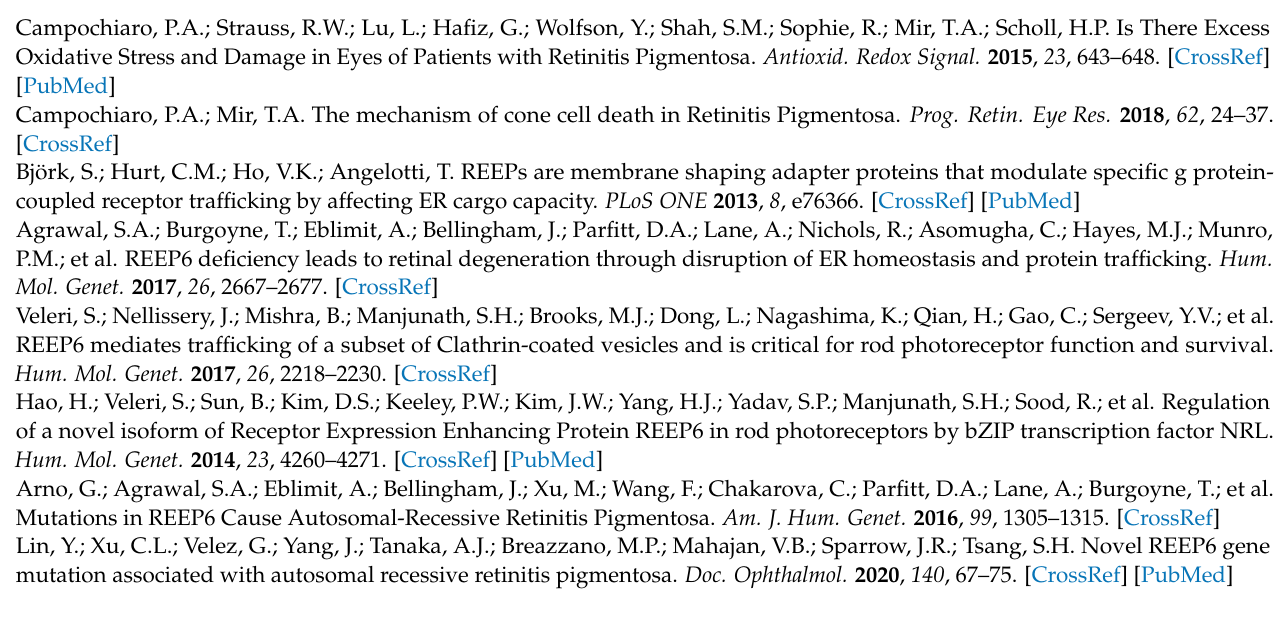
Table S1: Allele frequency in population of REEP6 c.268G>C, Table S2: In silico prediction of REEP6 c.268G>C, Table S3: Predicted protein physico-chemical parameters and structural modifications are as shown, Table S4. Supported evidence of three novel